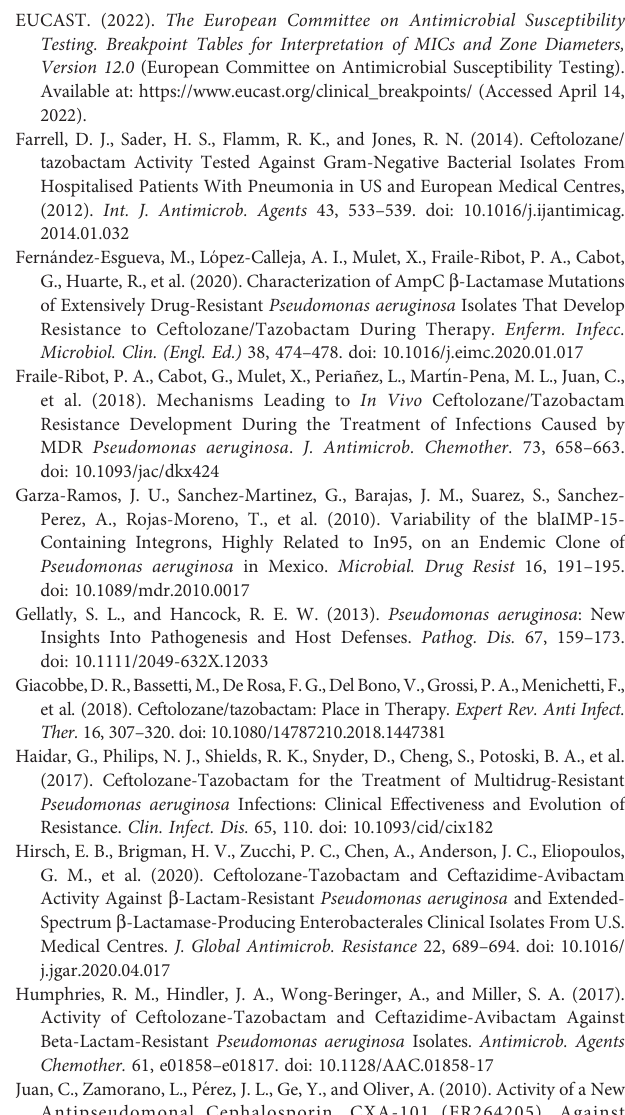
Supplementary Table 1 | List of the isolates ’ accession